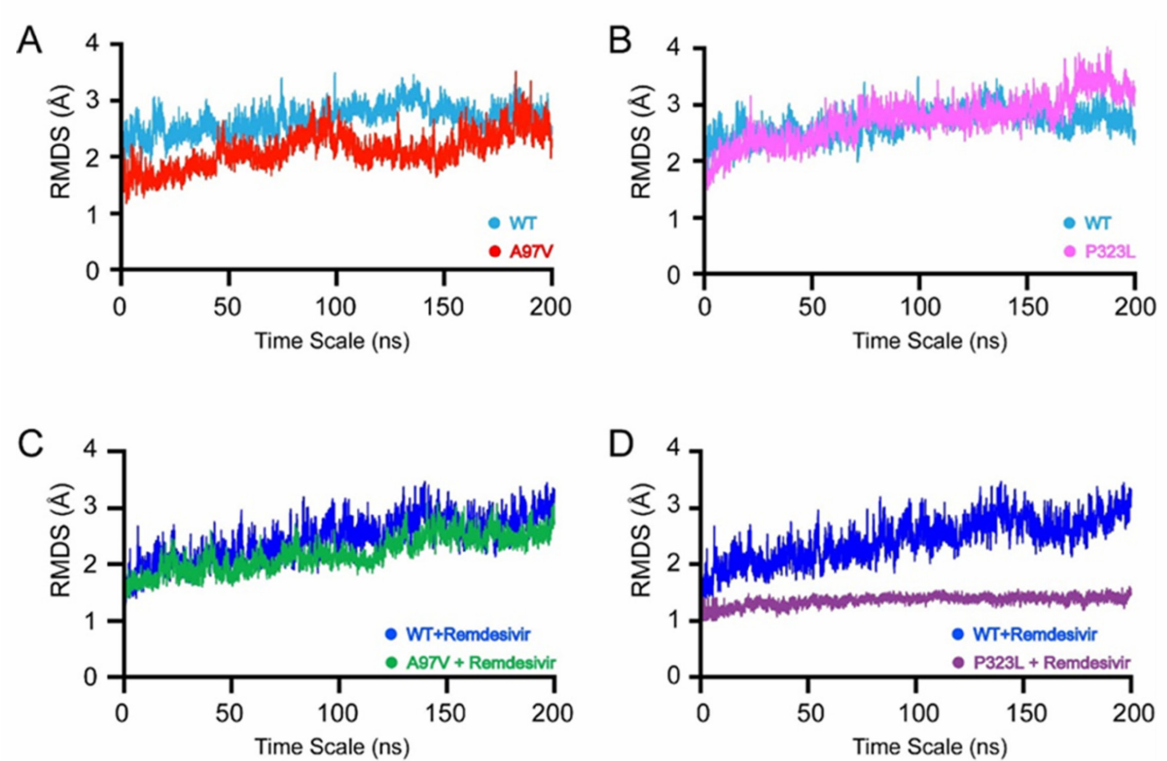
Figure 3. RMSD plots of 200-ns molecular dynamic simulations of RdRp in apo and complex with RDV. ( A ) WT − apo and A97V − apo, ( B ) WT − apo and P323L, ( C ) WT − RDV and A97V − RDV complex ( D ) WT − RDV and P323L − RDV